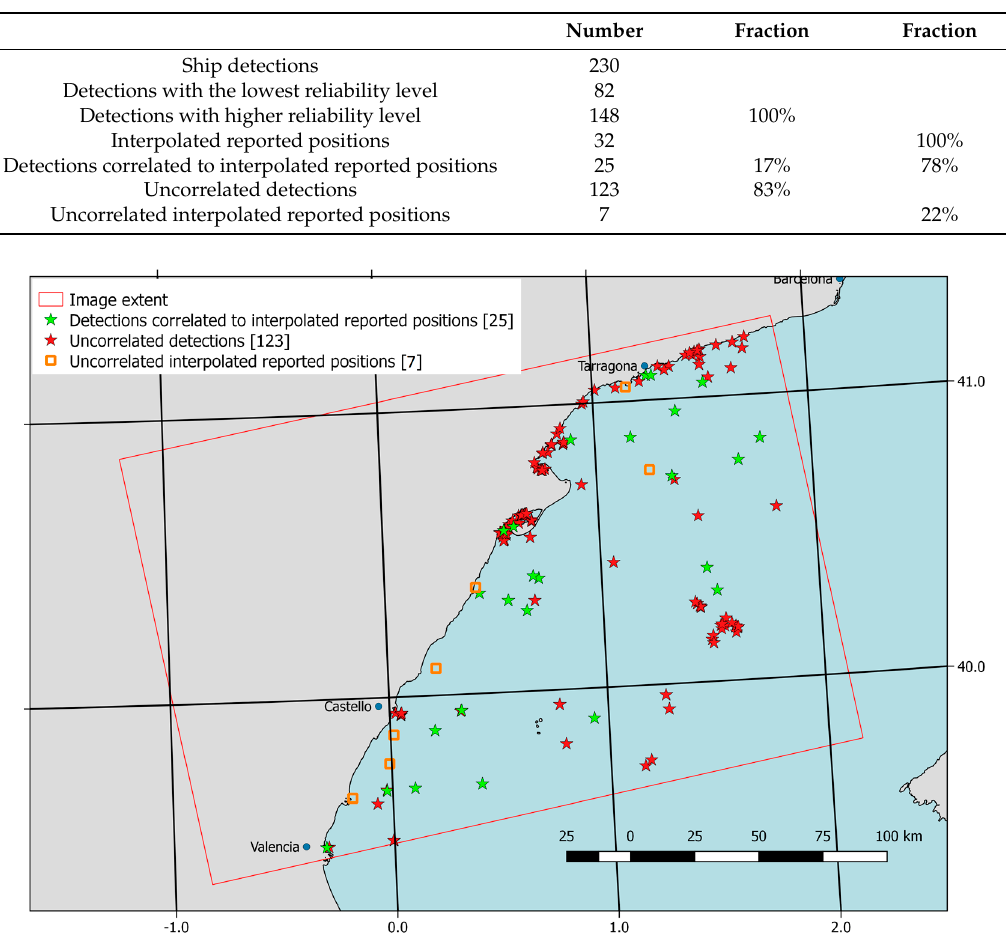
Table 4. Summary of ship detection and correlation results for the example image. Only interpolated reported ship positions outside the land mask are taken into account.